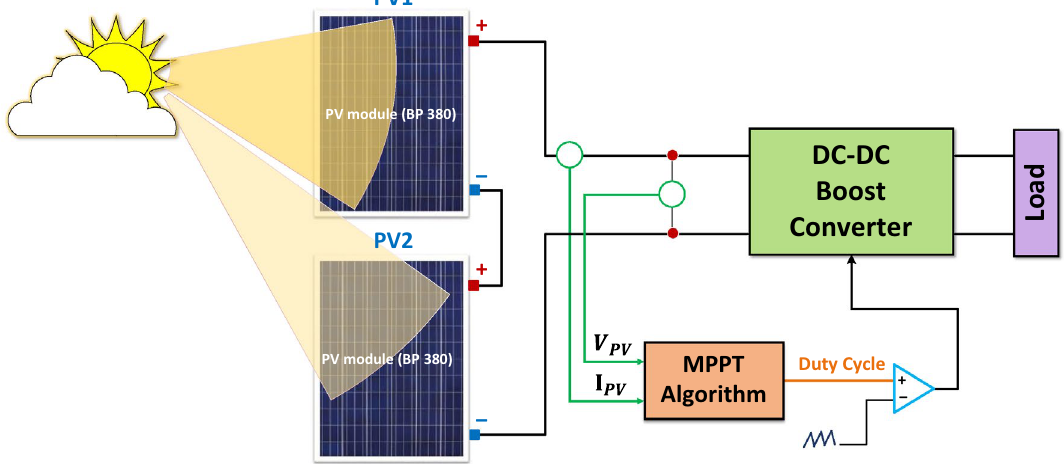
Figure 7. The block diagram used to realize the proposed MPPT method.